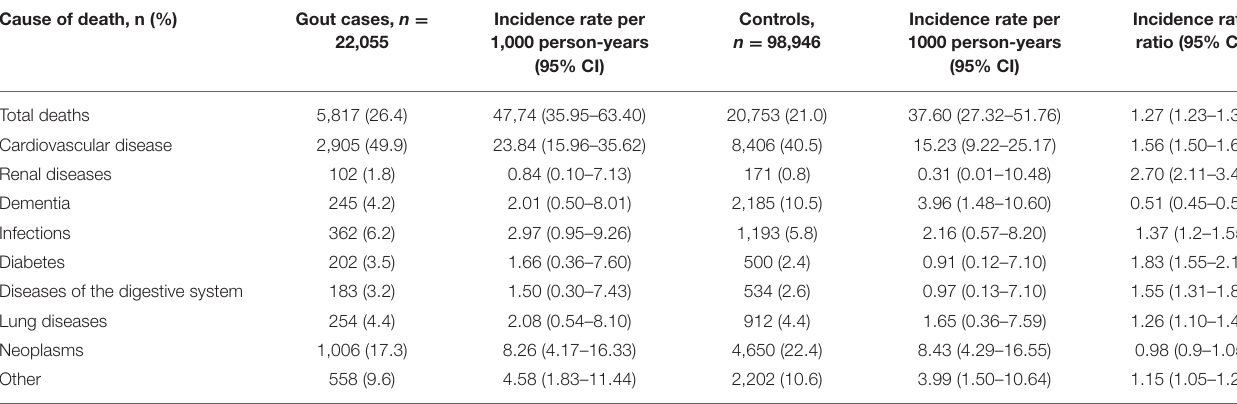
TABLE 3 | Number of deaths and incidence rates, overall and cause-specific, in cases and controls. Cause of death, n